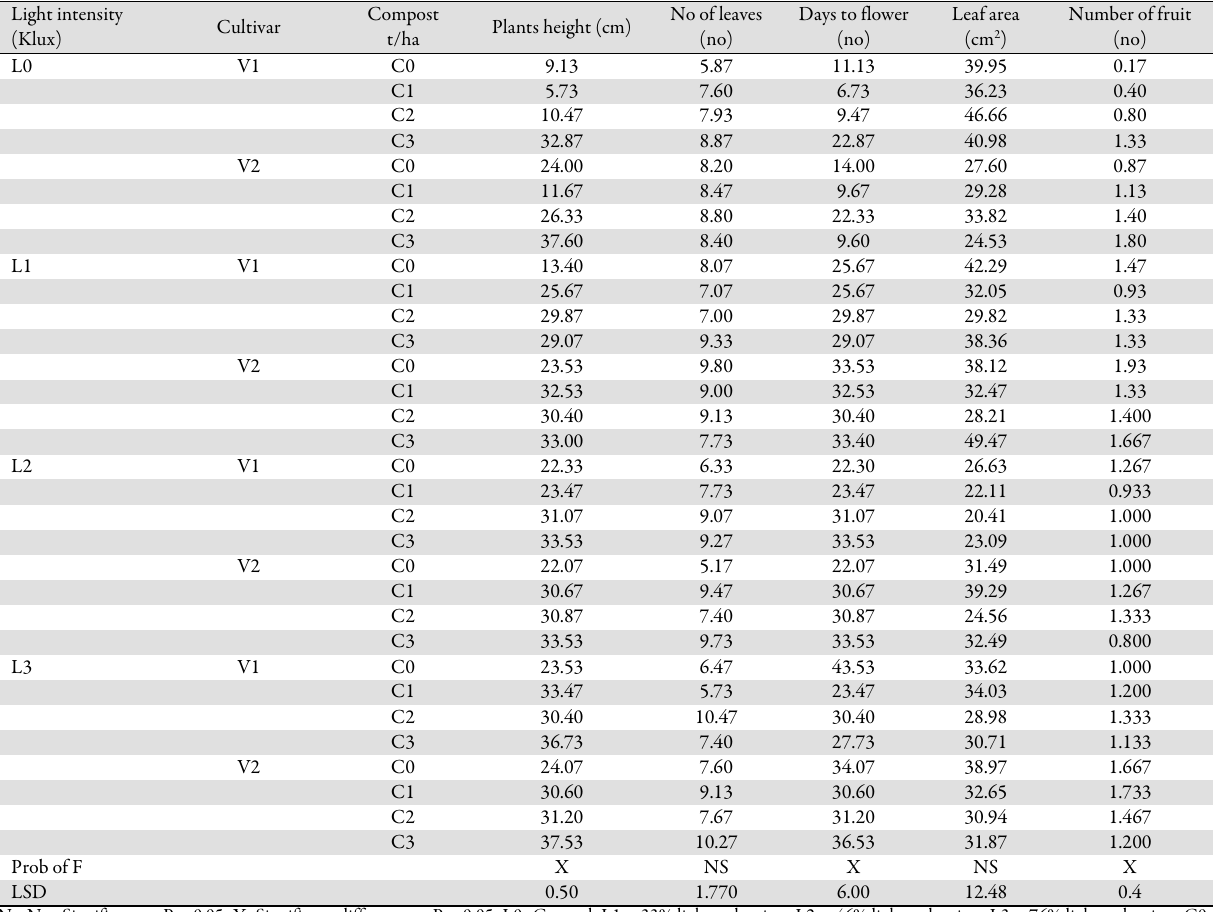
Table 4. Interactive effects of compost application and light intensity on the vegetative growth of two varieties of okra in the pot experiment Light